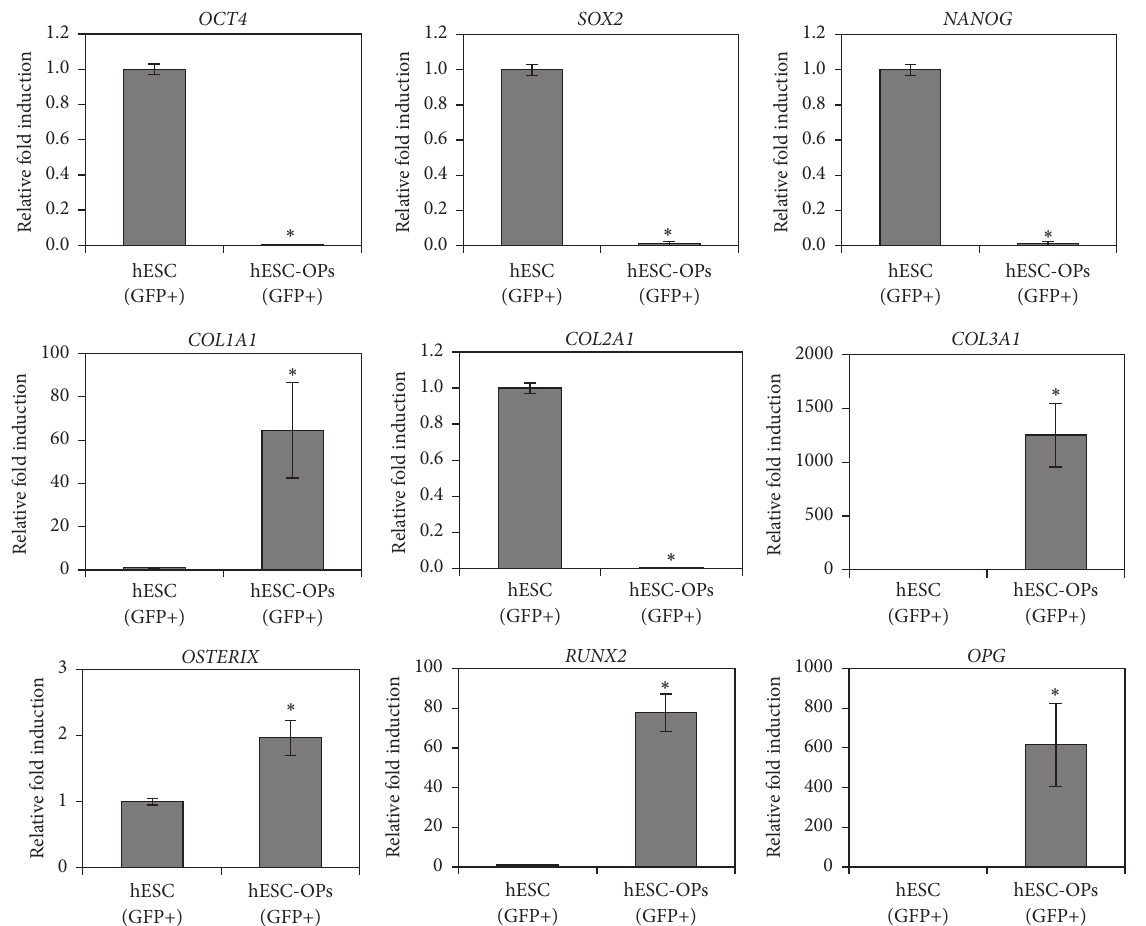
Figure 2: Characterization of hESC-OPs (GFP+) by real-time RT-PCR for pluripotency ( OCT4, SOX2, and NANOG ), mesenchymal ( COL1A1 and COL3A1 ), chondrogenic ( COL2A1 ), and osteogenic ( RUNX2 , OSTERIX , and OPG ) lineage-associated transcripts. The transcript levels were normalized to respective 𝛽 - Actin levels and to hESC (GFP+) cells. Values represent the means ± SD of three experiments ( ∗ 𝑝 < 0.05 versus hESC control).